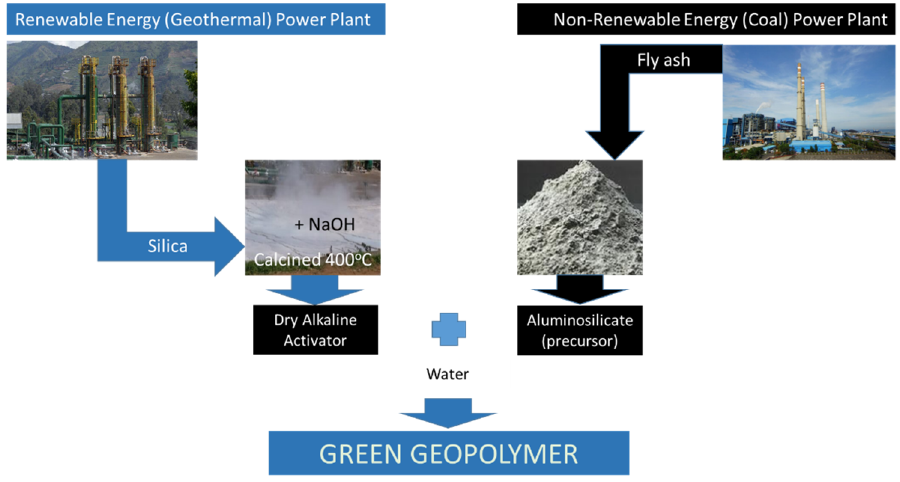
Figure 9. The Establishment of Circular Economy in coal and geothermal electric power generation.